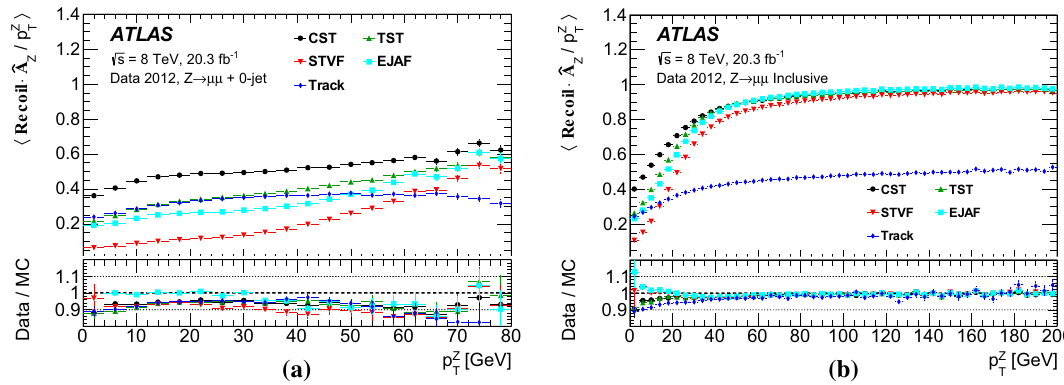
(cid:5) as a function p Z Fig. 10 (cid:4) (cid:3) R · ˆ A Z / p Z for the a 0-jet and b inclusive events in Z → μμ data. The insets at the bottom of the figures show the T T ratios of the data to the MC predictions